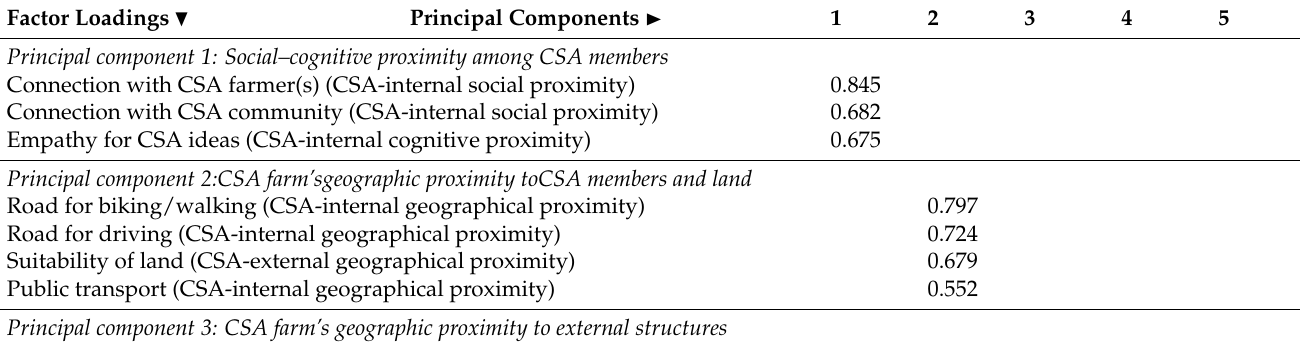
Table 4. Results of the principal component analysis and the reliability analysis ( n =